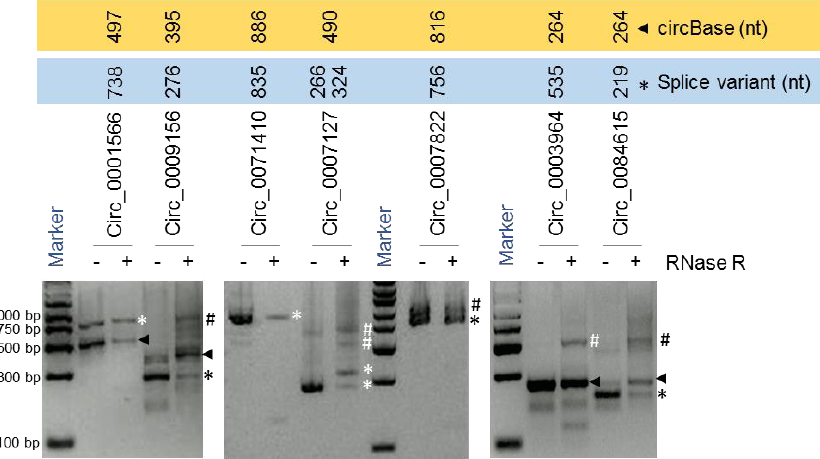
Figure 3. circRNA-RCA for full-length circRNA amplification. RT-PCR products amplified with full-length PCR primers and resolved on SYBR Gold-stained, 2% agarose gels. Arrowheads represent the sequence reported by circBase, while asterisks represent the splice variants. Hashtags represent either the doublets of circRNA or other circRNA isoforms or nonspecific products.